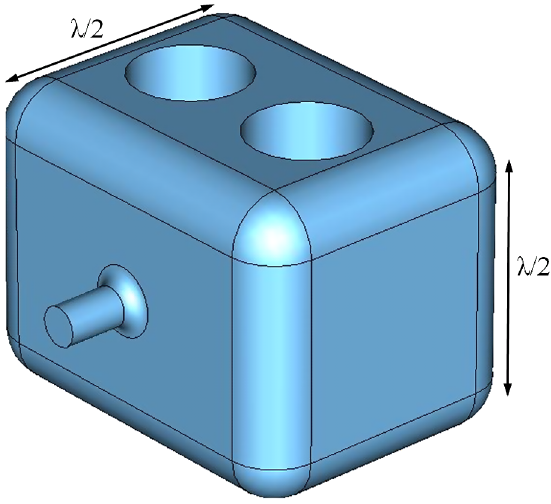
FIG. 3. Parallel-bar geometry with a rectangular-shaped outer conductor and cylindrical loading